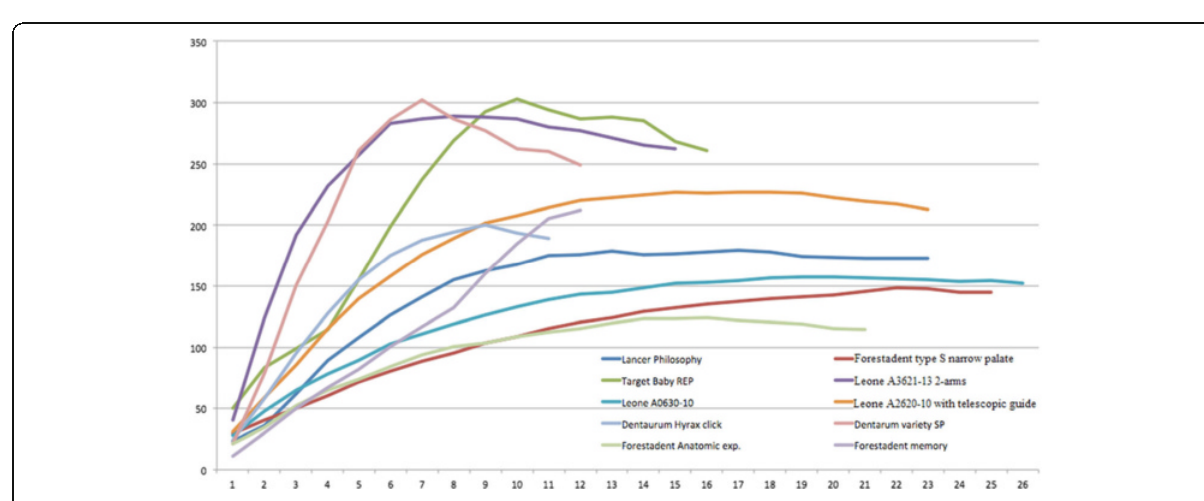
Fig. 5 Results of the RPE stiffness tests